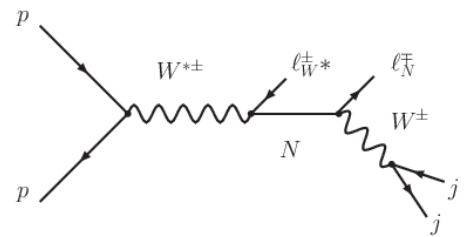
Figure 1 . The Feynman diagram depicting the dominant signal production mechanism for heavy neutrino masses and center-of-mass energies as considered in this